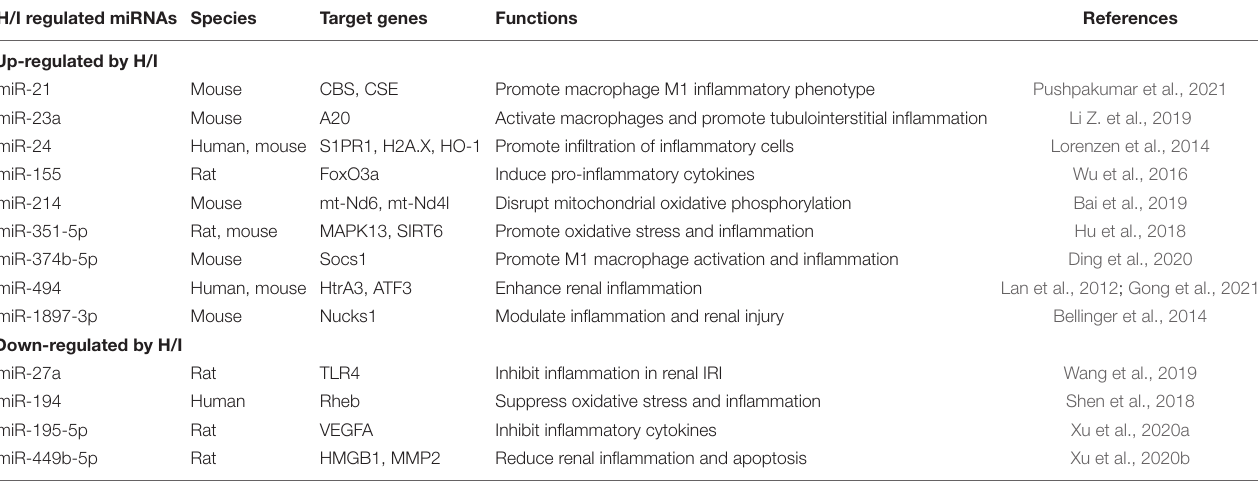
TABLE 1 | H/I-induced changes of miRNAs in the kidney with defined target genes.